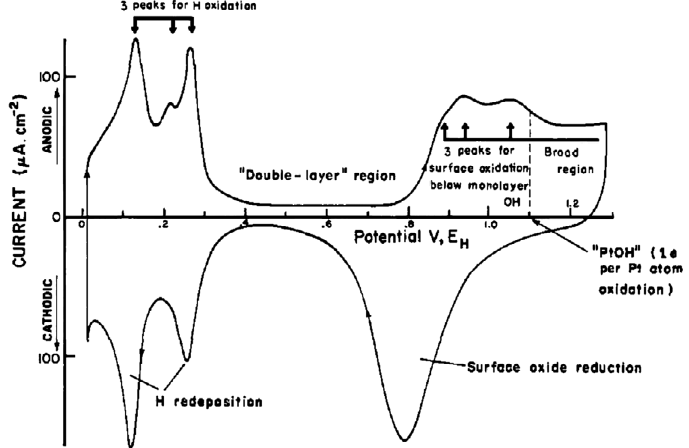
Fig. 7. – Cyclic votrammogram: Potentiodynamic current-potential profile for a polycrystalline platinum electrode in pure aqueous sulfuric acid. Figure adapted with permission from